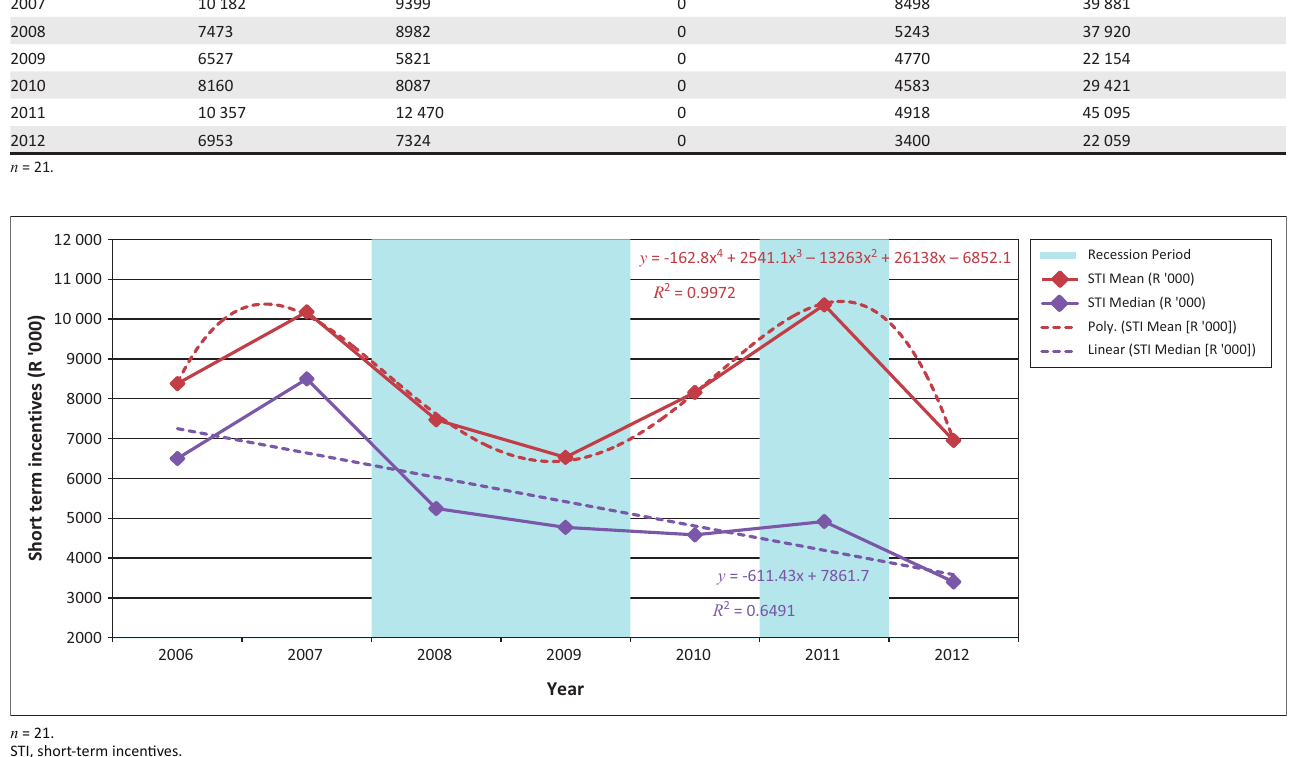
the organisation performance measures.